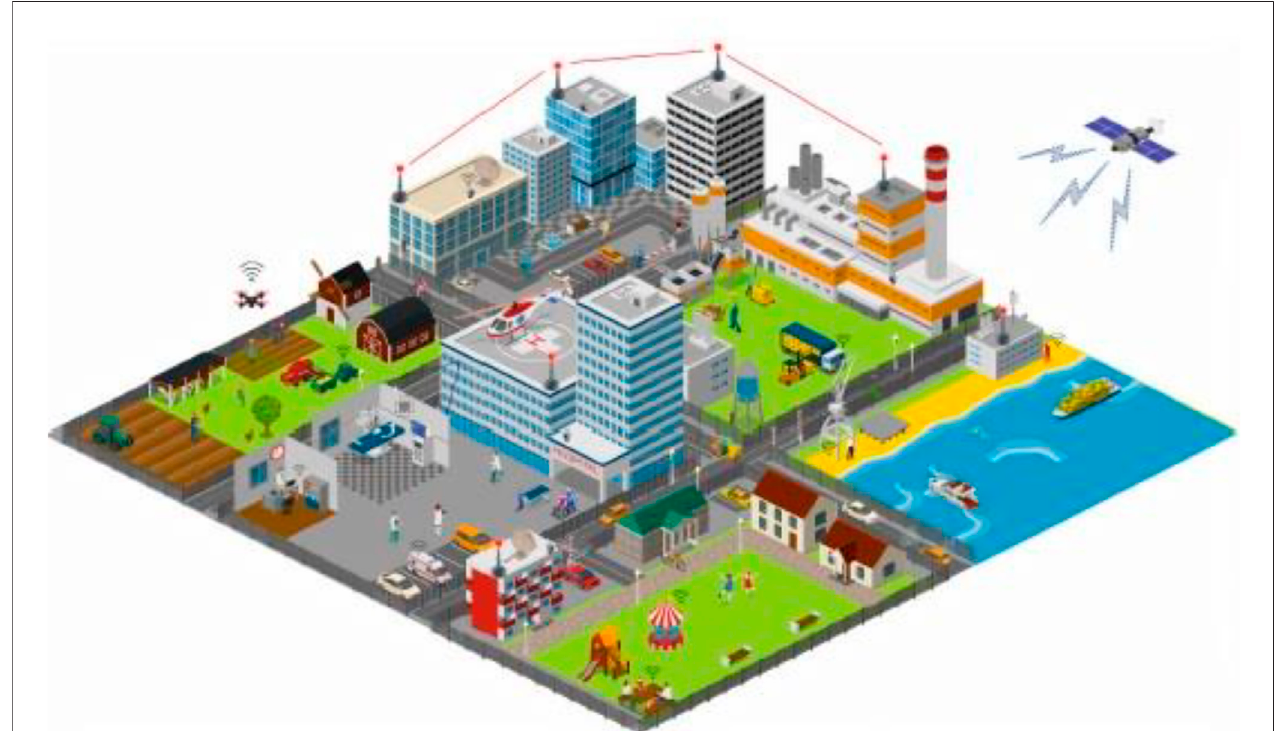
FIGURE 1 | FSO-enabled smart city network